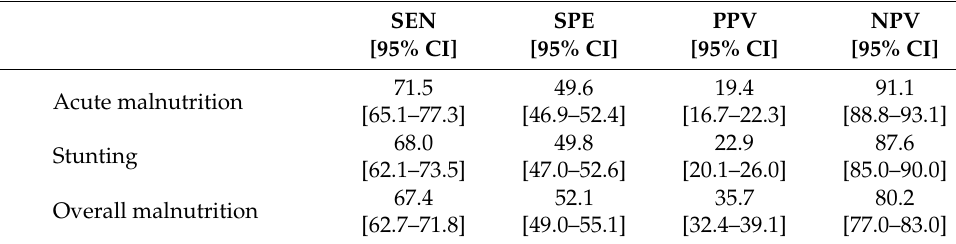
Table 4. Concurrent validity of STRONGkids among children admitted due to acute